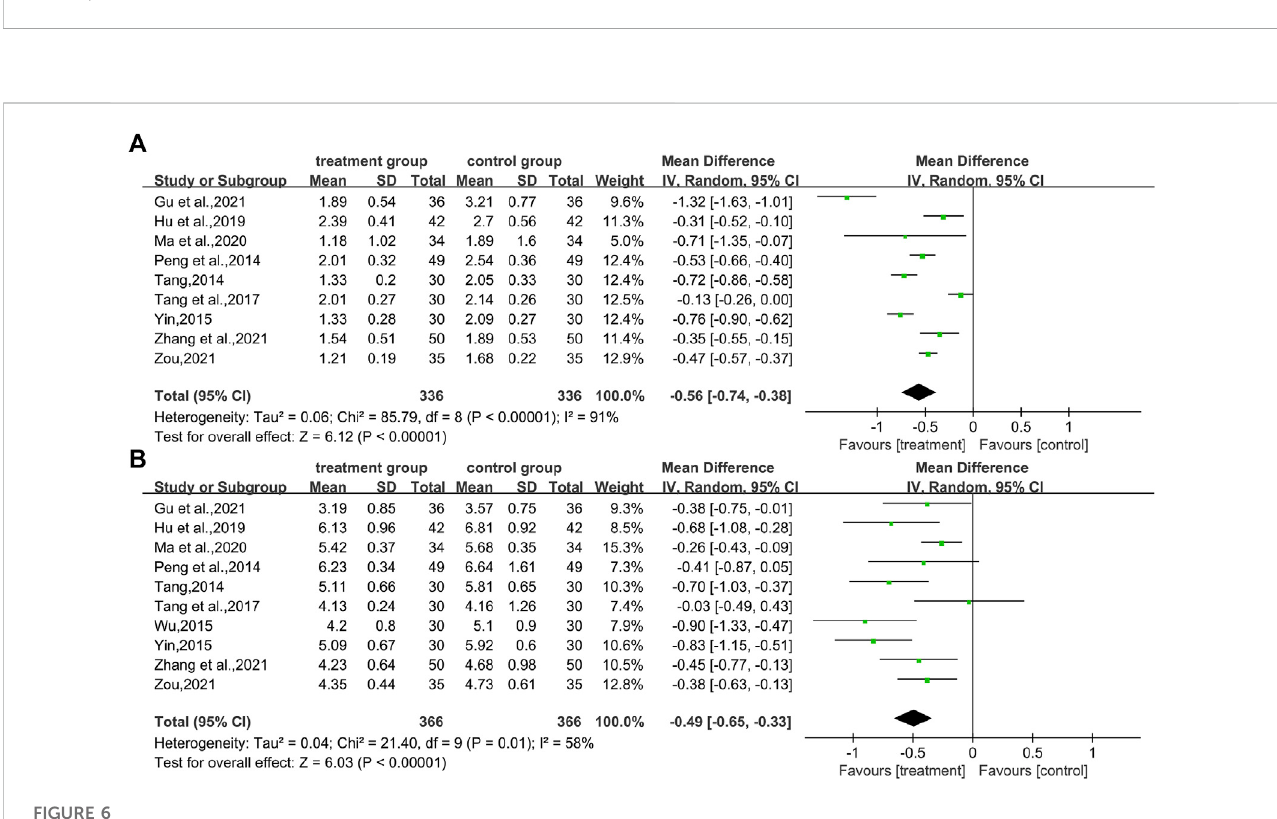
FIGURE 6 Forest plot for lipid indices. (A) TG; and (B)